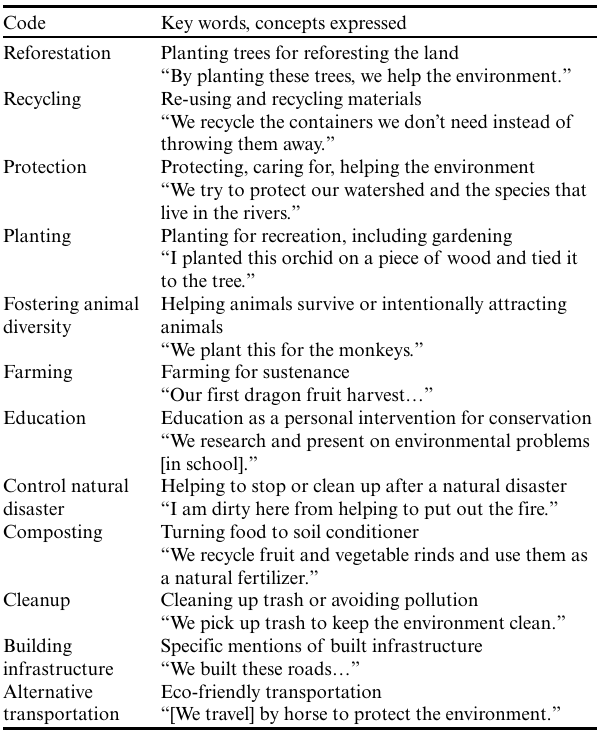
Table 5 . Codes for conservation actions (prompt 2).